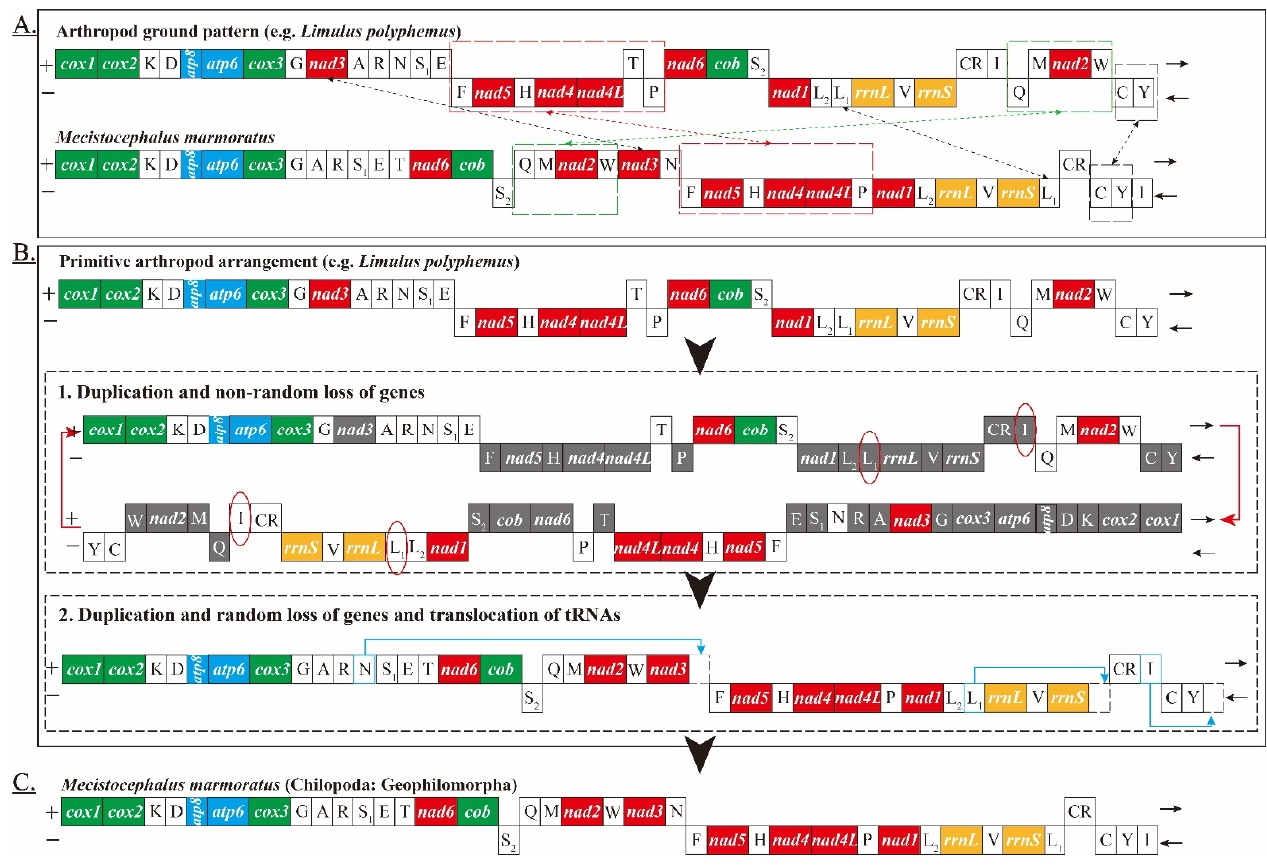
Figure 4. Inferred intermediate steps between Limulus polyphemus and M. marmoratus . The lost genes are labeled in gray. ( A ) The ancestral gene arrangement of the myriapod. ( B1 ) Two monomers derived from the duplication of the ancestor arranged in a circular dimer. Subsequently, nonrandom loss occurred according to the orientation of transcription for each gene. ( B2 ) Tandem duplication followed by the random loss of genes and the translocation of tRNAs. ( C ) Final gene orders of the M. marmoratus mitogenome.